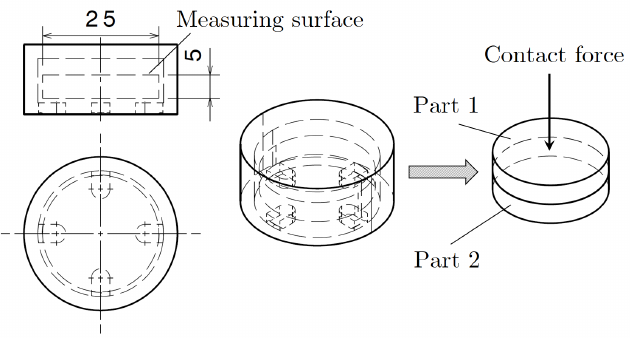
Figure 9. Specimen used to evaluate the influence of the contact pressure on the sintered joint (dimensions in